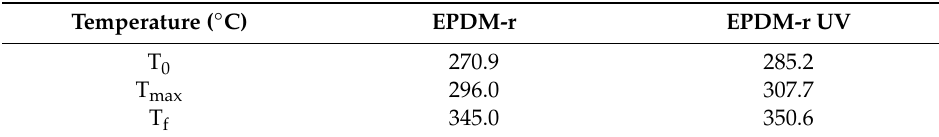
Table 3. Degradation start temperature (T 0 ), maximum degradation temperature (T max ), and final degradation temperature (T f ) related to the processing oil mass loss of the EPDM-r and the EPDM-r UV samples.